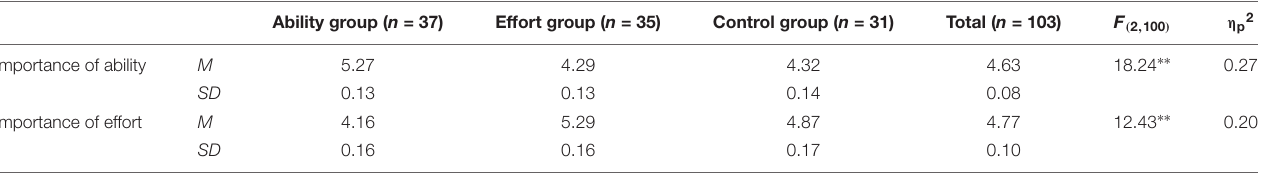
TABLE 1 | Descriptive statistics for children’s ratings on the importance of ability and effort. Ability group ( n = 37) Effort group ( n = 35)